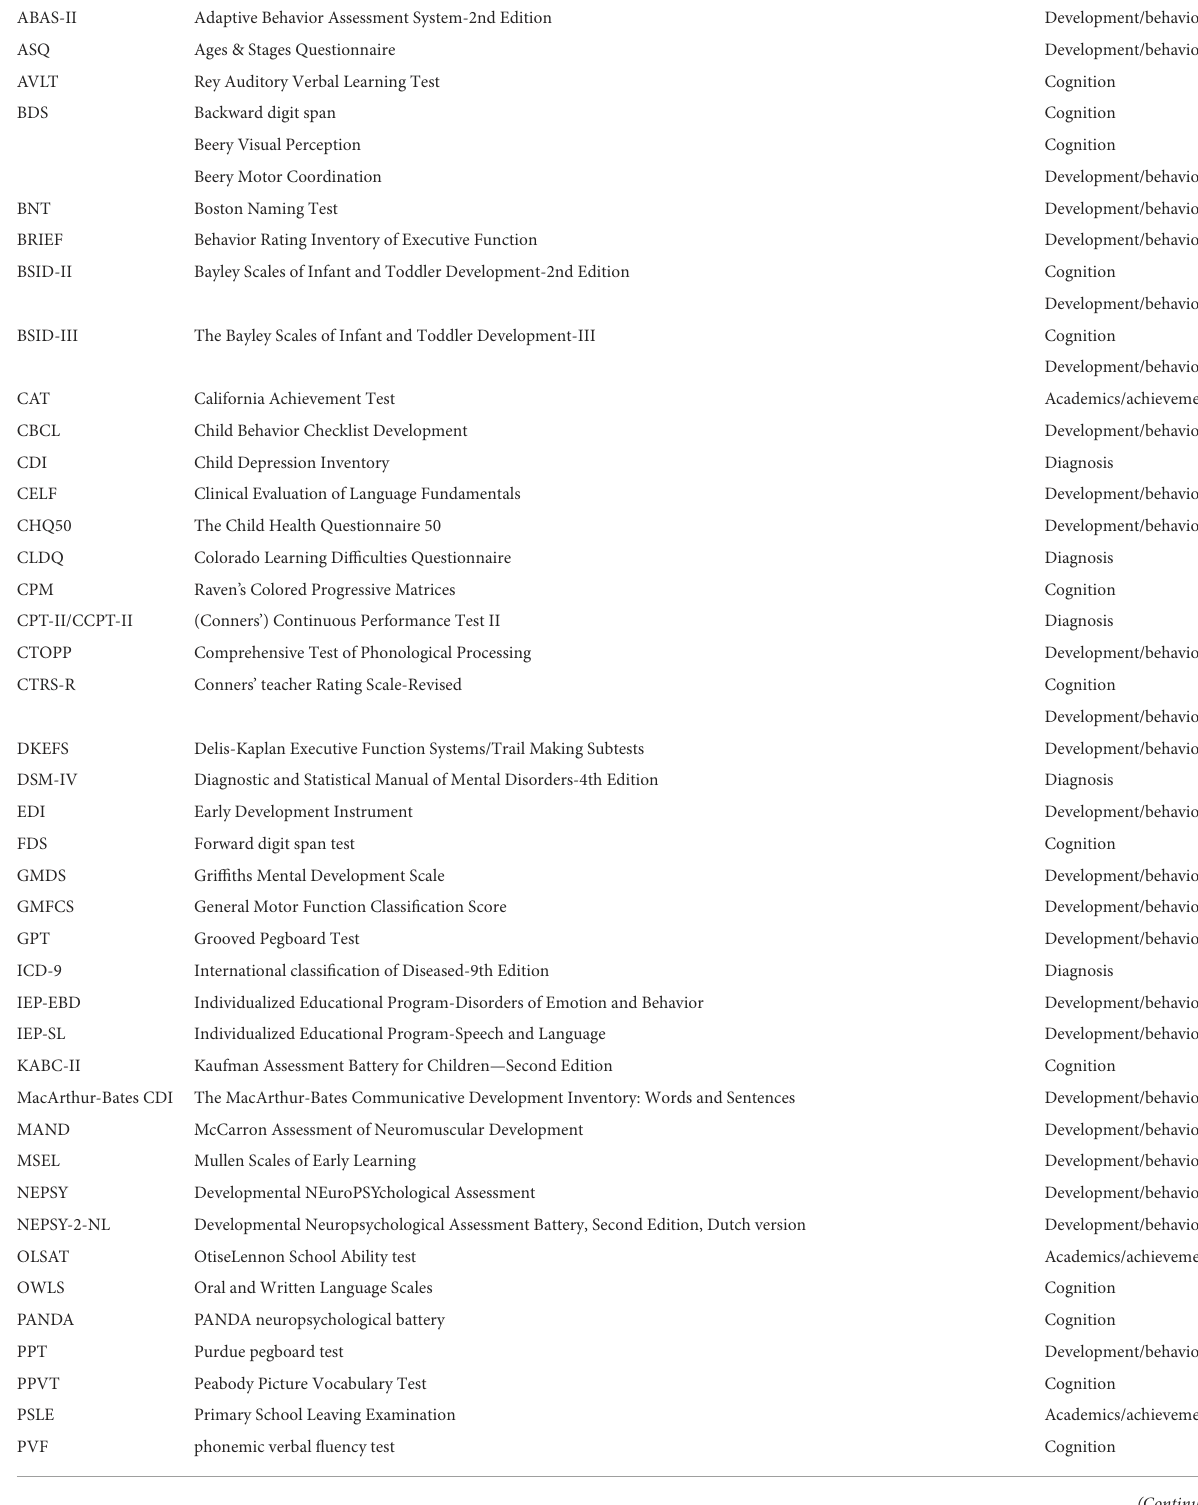
TABLE 2 List of miscellaneous neurocognitive tests utilized to assess neurodevelopment of children exposed to general anesthesia (alphabetic order) and the domain to which the test was assigned. Psychometric